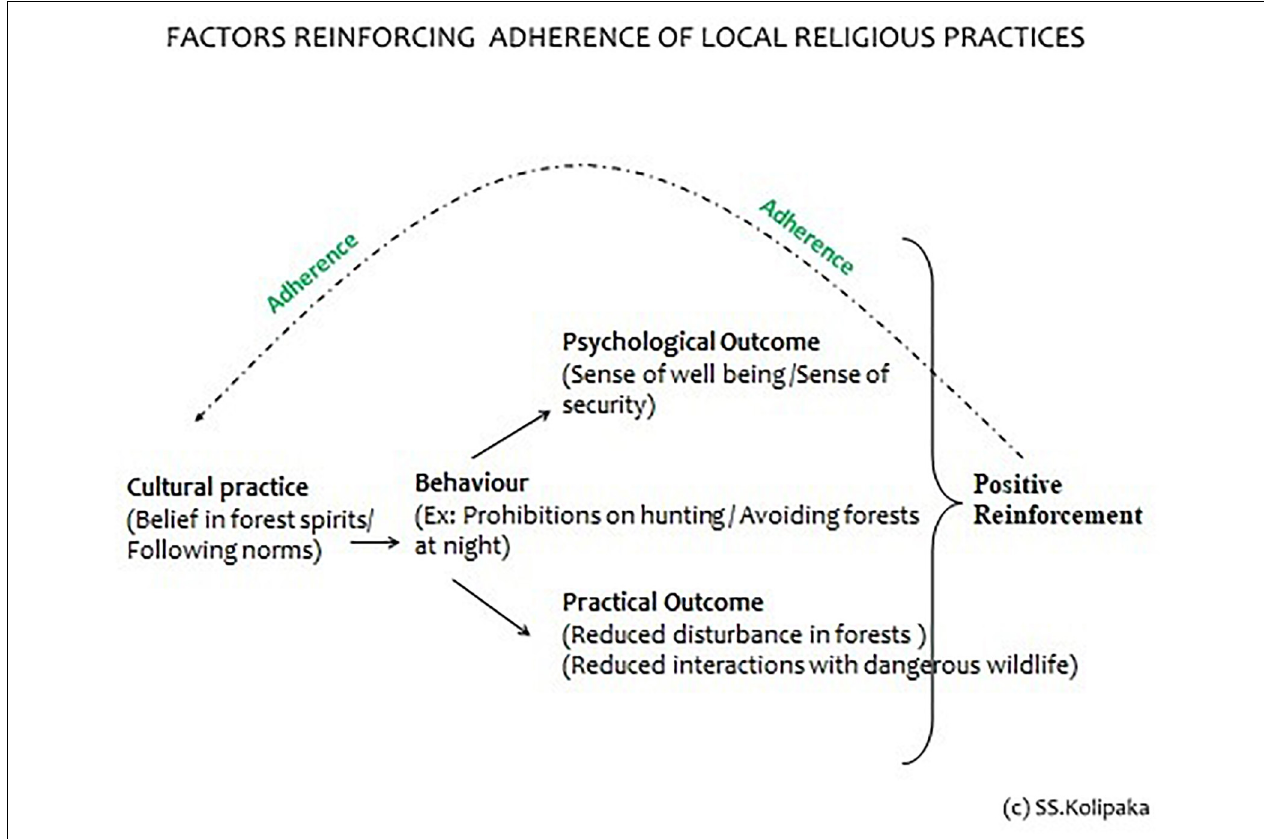
FIGURE 6 | Schematic showing links between local practices, derived benefits, and motivation for continued adherence to practices in India (Kolipaka